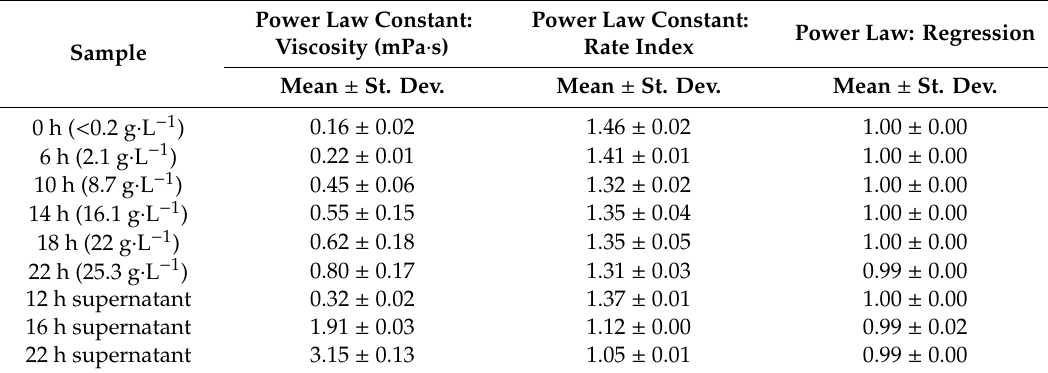
Table 1. Summary of model parameters ( n = 3) for fitting the obtained data from each sample with the power